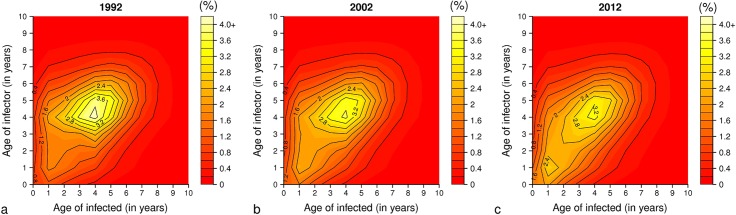
Infection matrices over time.a Fraction of varicella cases (%) generated by contacts of susceptible individuals of age i (x axis) with infected individuals of age j (y axis), as estimated by model M2 in the year 1992 (average over 100 simulation runs with the mean estimates of model parameters). b The same as a but for 2002. c The same as a but for 2012.